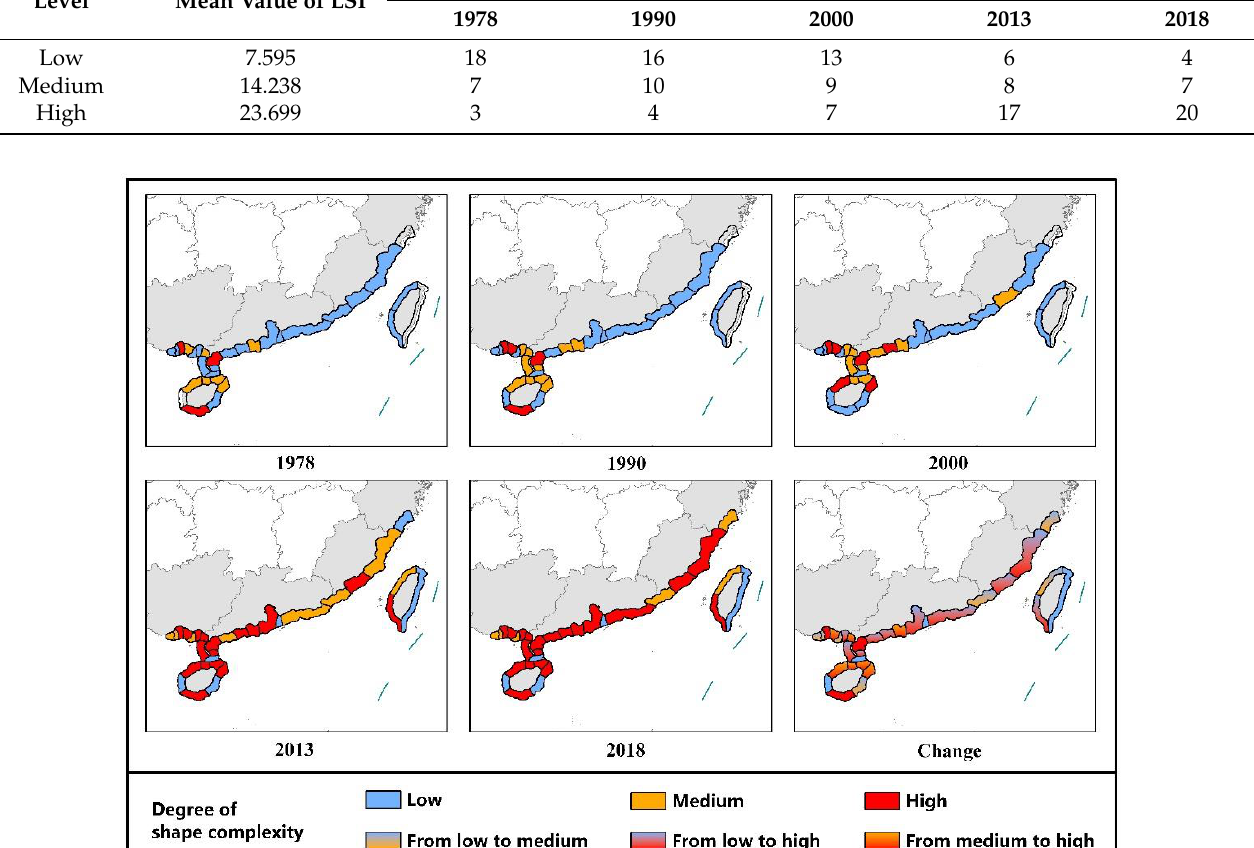
Figure 4. Temporal and spatial variations in the shape